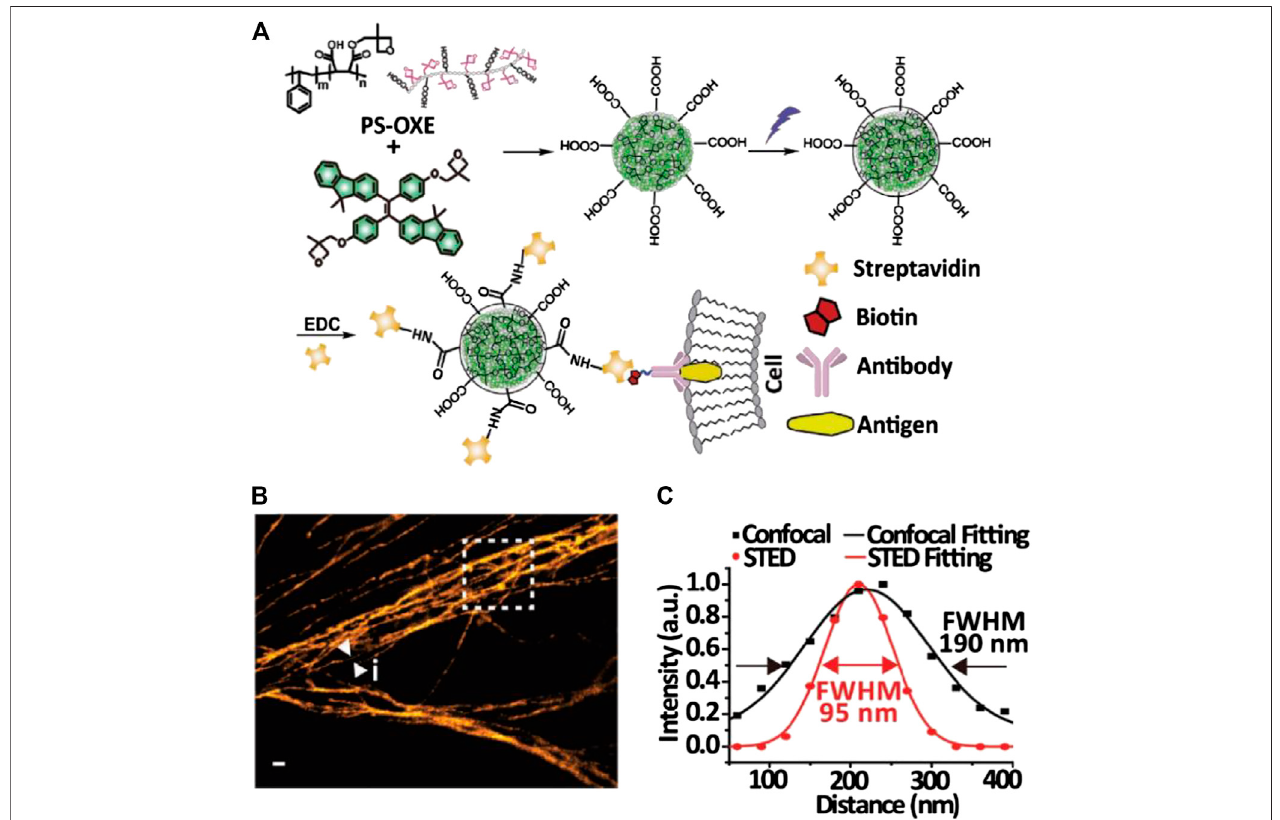
FIGURE 4 | Bioconjugated AIE dots for STED imaging (Fang et al., 2017). (A) Synthesis and modi fi cation of AIE dots for speci fi c labeling. (B) STED microscopy image of microtubules in MCF-7 cells labeled with AIE dots. (C) Plot fi le for confocal and STED imaging results in the selected area.